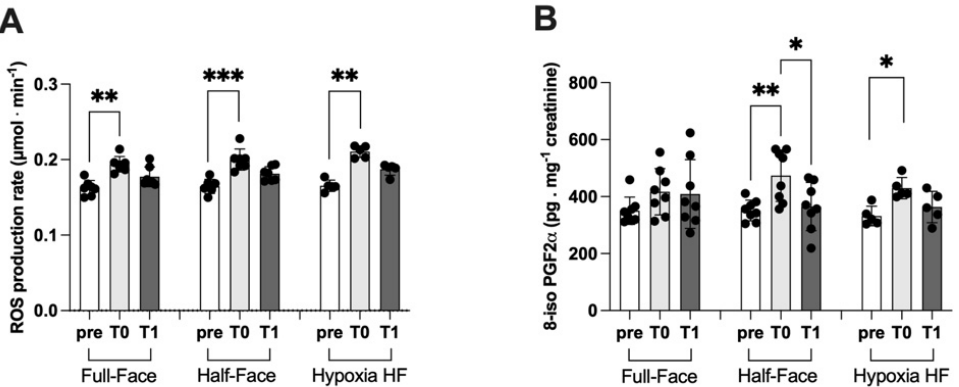
Figure 3. Panels show the histogram plot (mean ± SD) of ( A ) ROS production (EPR), and ( B ) 8-iso PGF2- α concentration (ELISA). * p < 0.05, ** p < 0.01, *** p < 0.001 significant difference.